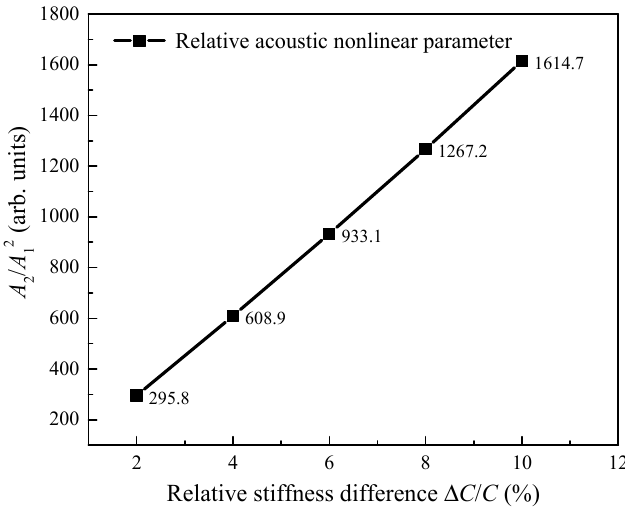
Figure 7. Relative acoustic nonlinear parameter at a sensing point (47.7, 18.5) mm versus the relative stiffness difference (from 2% to 10%).